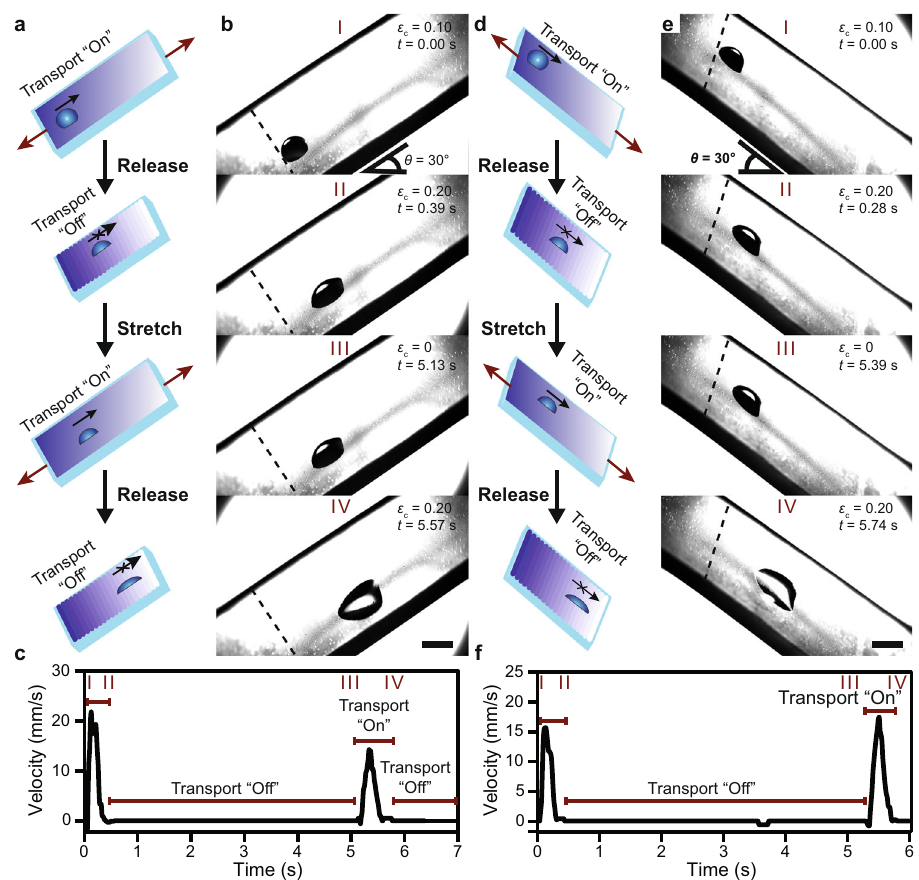
Fig. 4 Controlling droplet transport dynamically along inclined surfaces using mechanical deformations. a General schematic and b optical micrographs demonstrating dynamic toggling of fl uid transport between “ on ” and “ off ” states on a 30° inclined plane. c Temporal velocity pro fi le of the microdroplet extracted from the control sequence in b . d General schematic and e optical micrographs demonstrating dynamic toggling of fl uid transport between “ on ” and “ off ” states on a 30° declined plane. f Temporal velocity pro fi le of the microdroplet extracted from the control sequence in e . Scale bars = 2